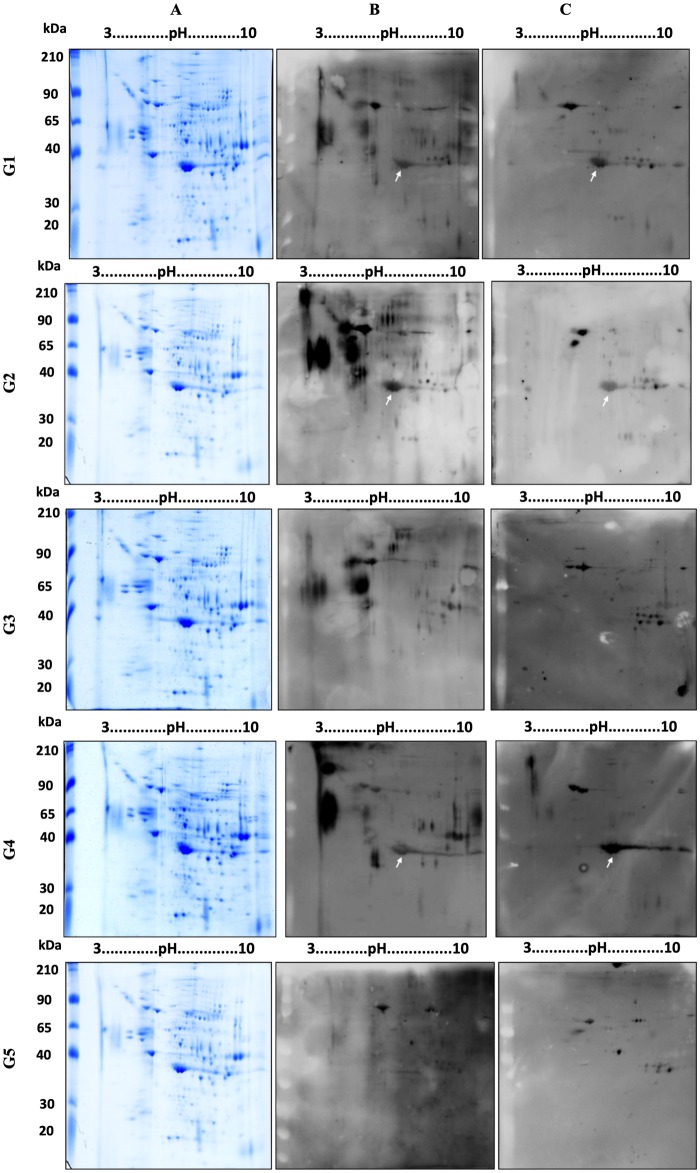
Two-dimensional analysis using Schistosoma mansoni egg extract and pooled sera from infected and non-infected individuals.A) 2D-PAGE of native SEE in 7 cm, pH 3–10 strip and stained by Coomassie G-250. B) Corresponding 2D-WB with pooled human sera and C) 2D-WB post membrane treatment with 10 mM of SMP. Sera from group 1, 2, 3 and 5 was added at 1:600 dilution. The sera from group 4 was added at 1:1200 dilution. The anti-human IgG peroxidase conjugate was added at 1:100,000. The white arrows indicate spot 5 corresponding to Major Egg Antigen. G1: S. mansoni chronic sera; G2: S. mansoni chronic sera after 180 days post treatment; G3: STH-positive sera (Ascaris lumbricoides, Trichuris trichiura and Ancylostoma); G4: S. mansoni acute sera, G5: negative sera from health donors.